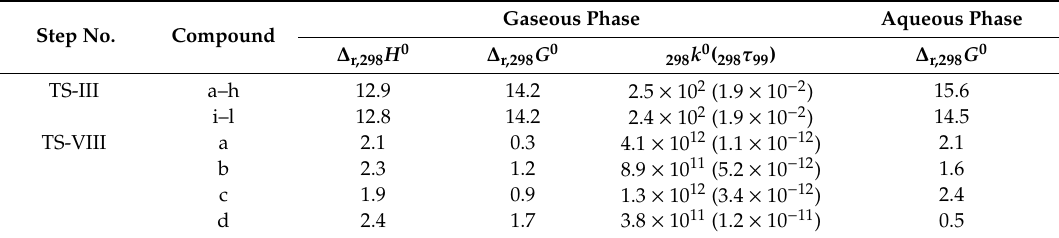
Table 2. Kinetic characteristics 1 of the selected steps of the CL reaction of